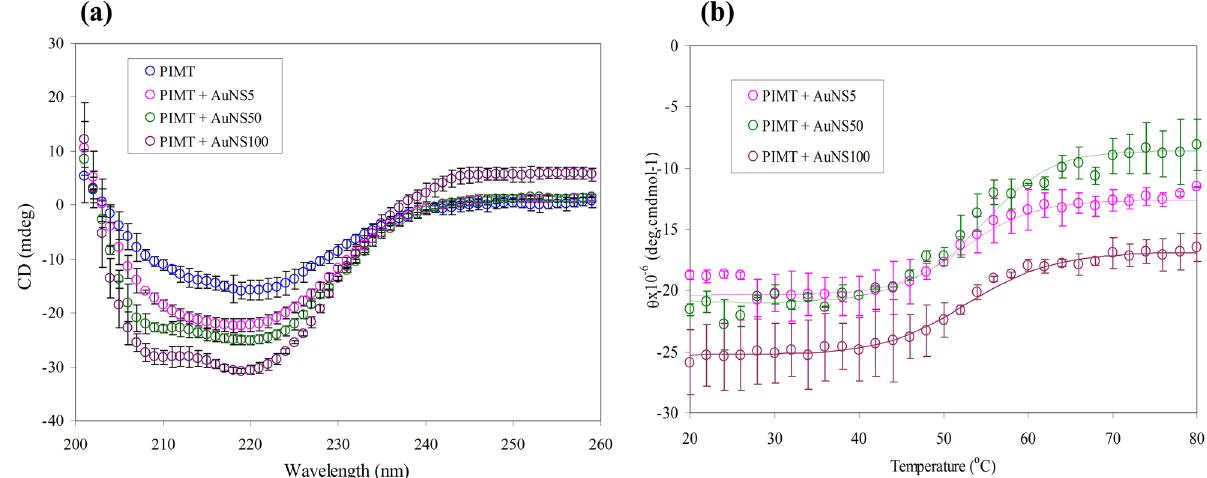
Figure 2. Far-UV CD of PIMT alone and in presence of ( a ) AuNSs of different sizes using 1:1 molar ratio in 0.1 M sodium phosphate buffer; pH 7.2 at 25 °C ( b ) Effect of temperature on the unfolding of PIMT in presence of AuNSs, as seen from the plot of the ellipticity at 222